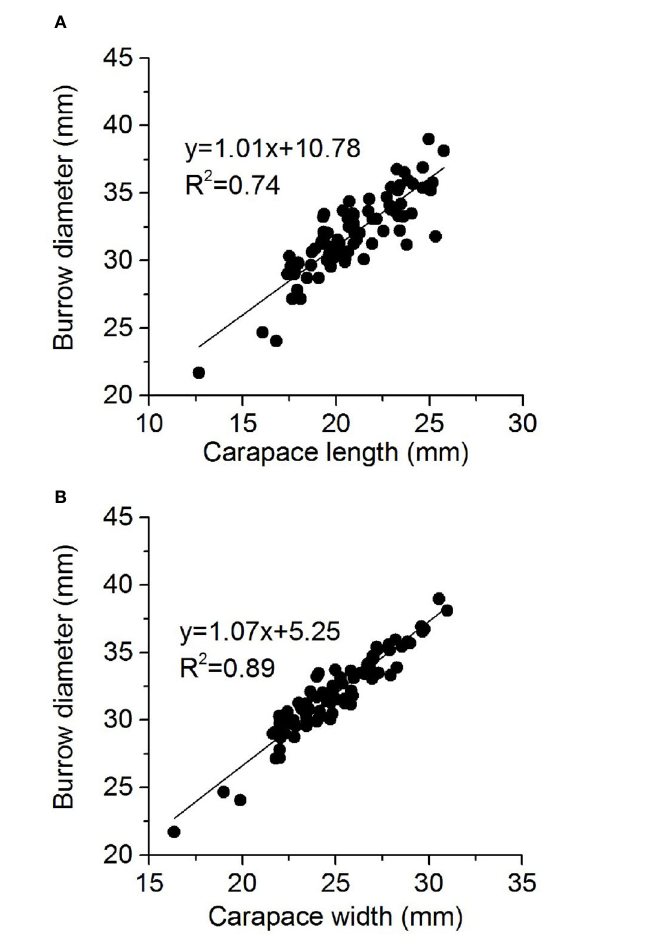
FIGURE 7 Relationship between Helice tientsinensis size (A) : carapace length and (B) : carapace width) and burrow